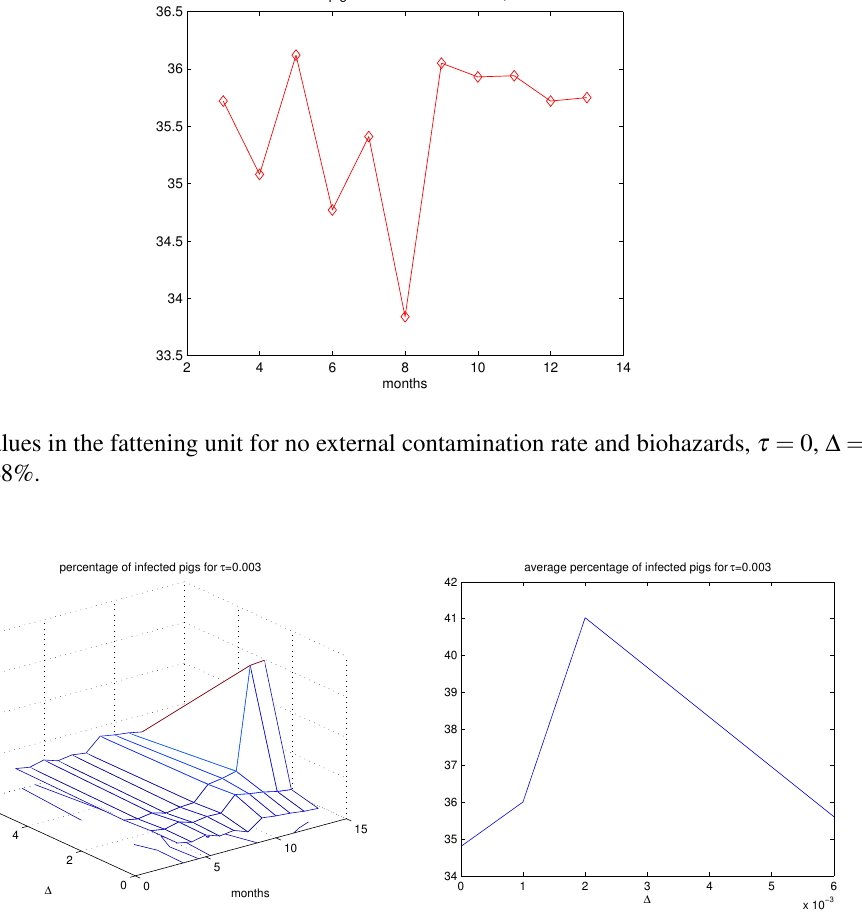
Fig. 11 Left: Percentage of infected pigs evolution in the fattening unit. Here we fix the value of external contamination rate at τ = 0 . 003. Right: Averages in time as function of ∆ of the percentage of infected pigs evolution in the fattening unit. Here we fix the value of external contamination rate at τ = 0 .